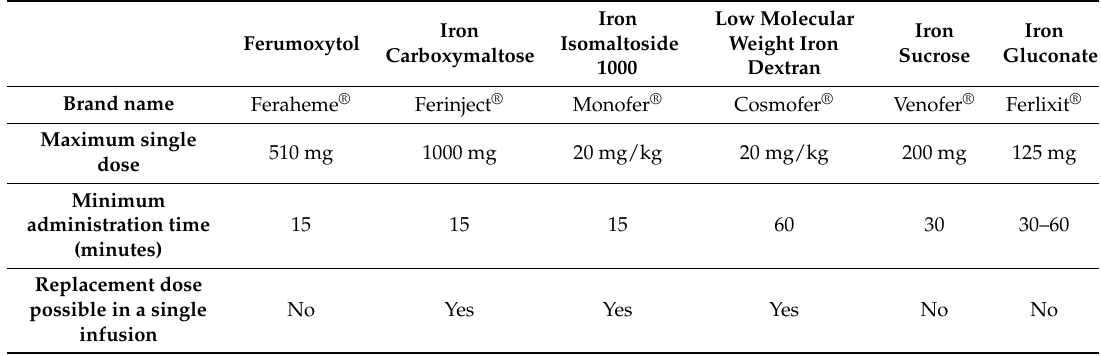
Table 2. Clinical characteristics of currently available IV irons [13,33,39].